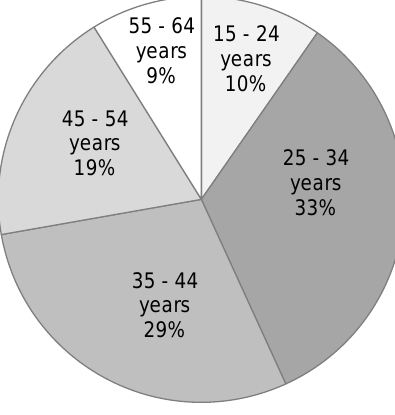
Figure 3: Labour force by age Much negativity surrounds outcomes-based education (OBE)